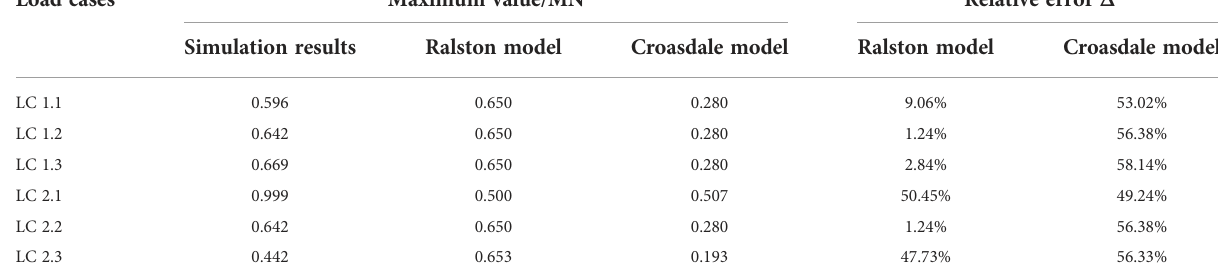
TABLE 5 Comparisons of vertical ice load statistics.